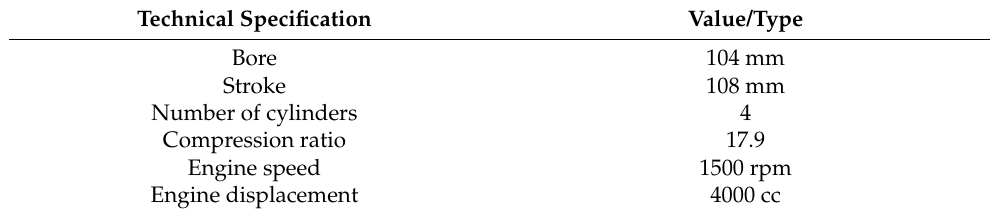
Table 1. Specification of HINO W04D diesel